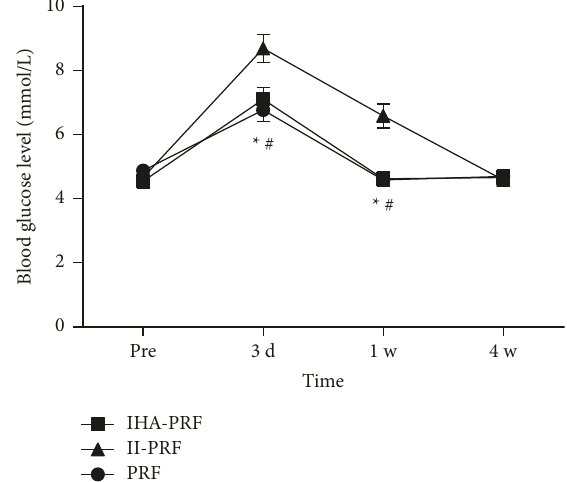
Figure 6: The blood glucose levels of patients in group IHA-PRF and group PRF decreased three days and one week after treatment.